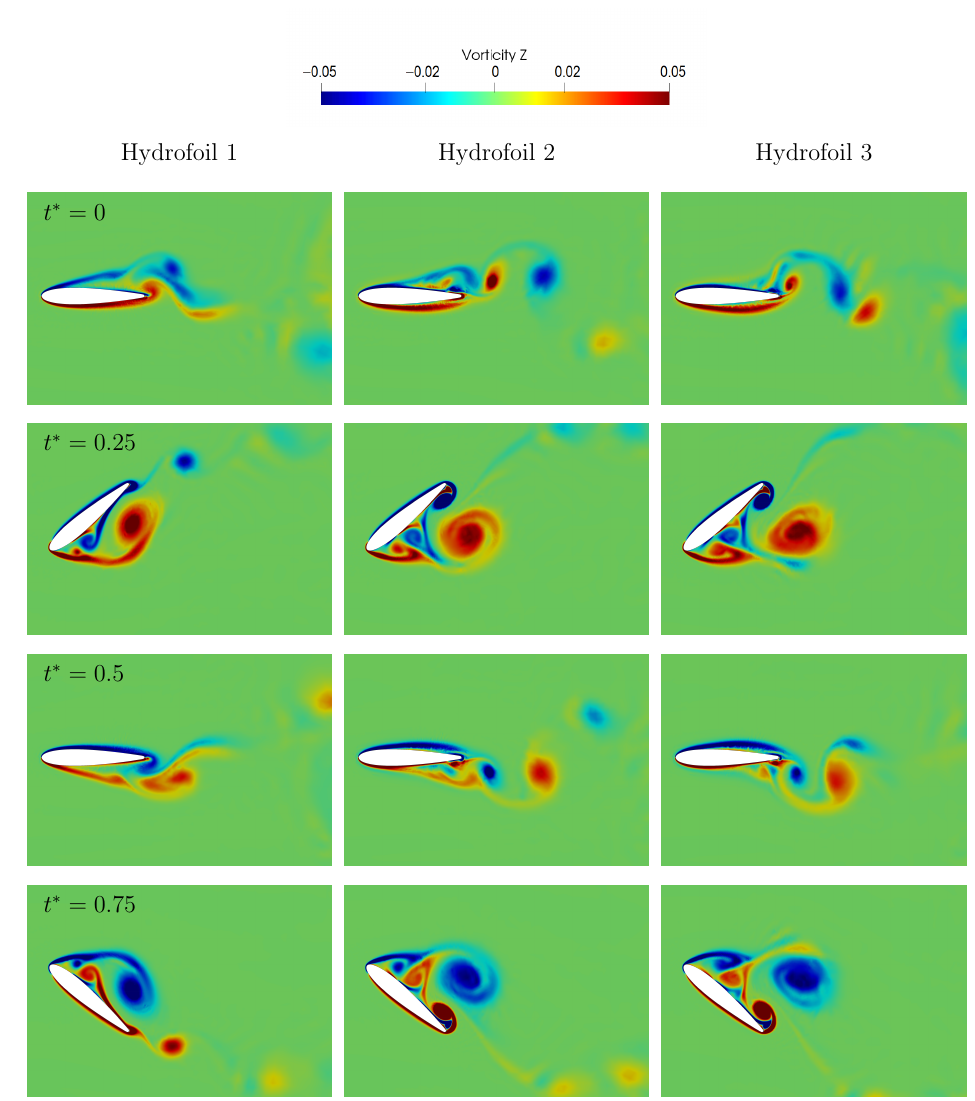
Figure 7. Instantaneous vorticity fields ω z around the oscillating hydrofoil for the hydrofoils 1, 2, and 3, α 0 = 40 ◦ , f ∗ = 0.025, ∆ h = 0.8 m, and t ∗ = 0, 0.25, 0.5,